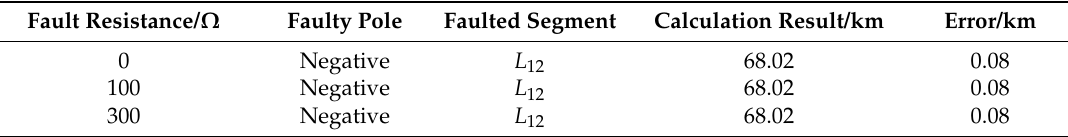
Table 6. Location results of fault with different fault